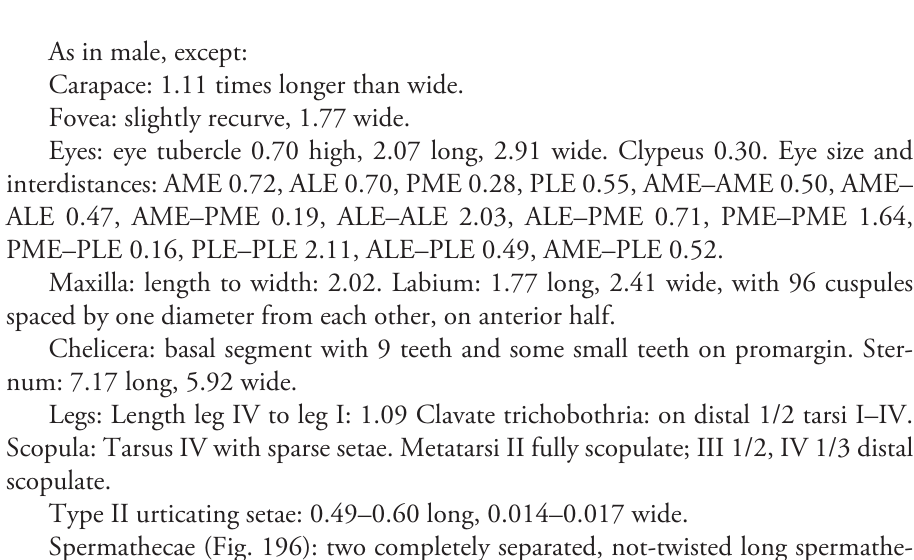
Color pattern (Fig. 199): as in